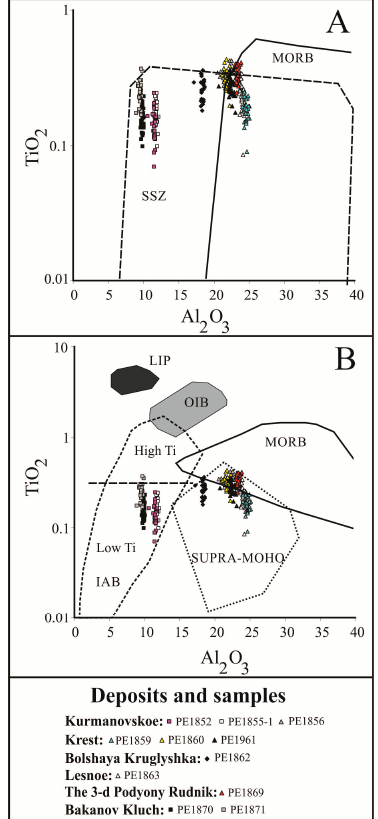
Figure 15. TiO 2 –Al 2 O 3 relationships in chromitites of Alapaevsk. ( A ) Composition of the chromitites, compared to the field of spinels from the supra-subduction zone (SSZ) and mid-ocean ridge (MOR) mantle peridotites (compositional fields from [34]); ( B ) the fields for IAB (island arc basalt), OIB (oceanic island basalt), MORB (mid-ocean ridge basalt), LIP (large igneous province) basalt, and supra-Moho (SUPRA-MOHO) chromitite from the Urals are from [6,36]. The horizontal dashed line at TiO 2 = 0.30 wt % separates the high-Ti IAB (high-K calc-alkaline suite) from the low-Ti IAB (boninitic, tholeiitic).